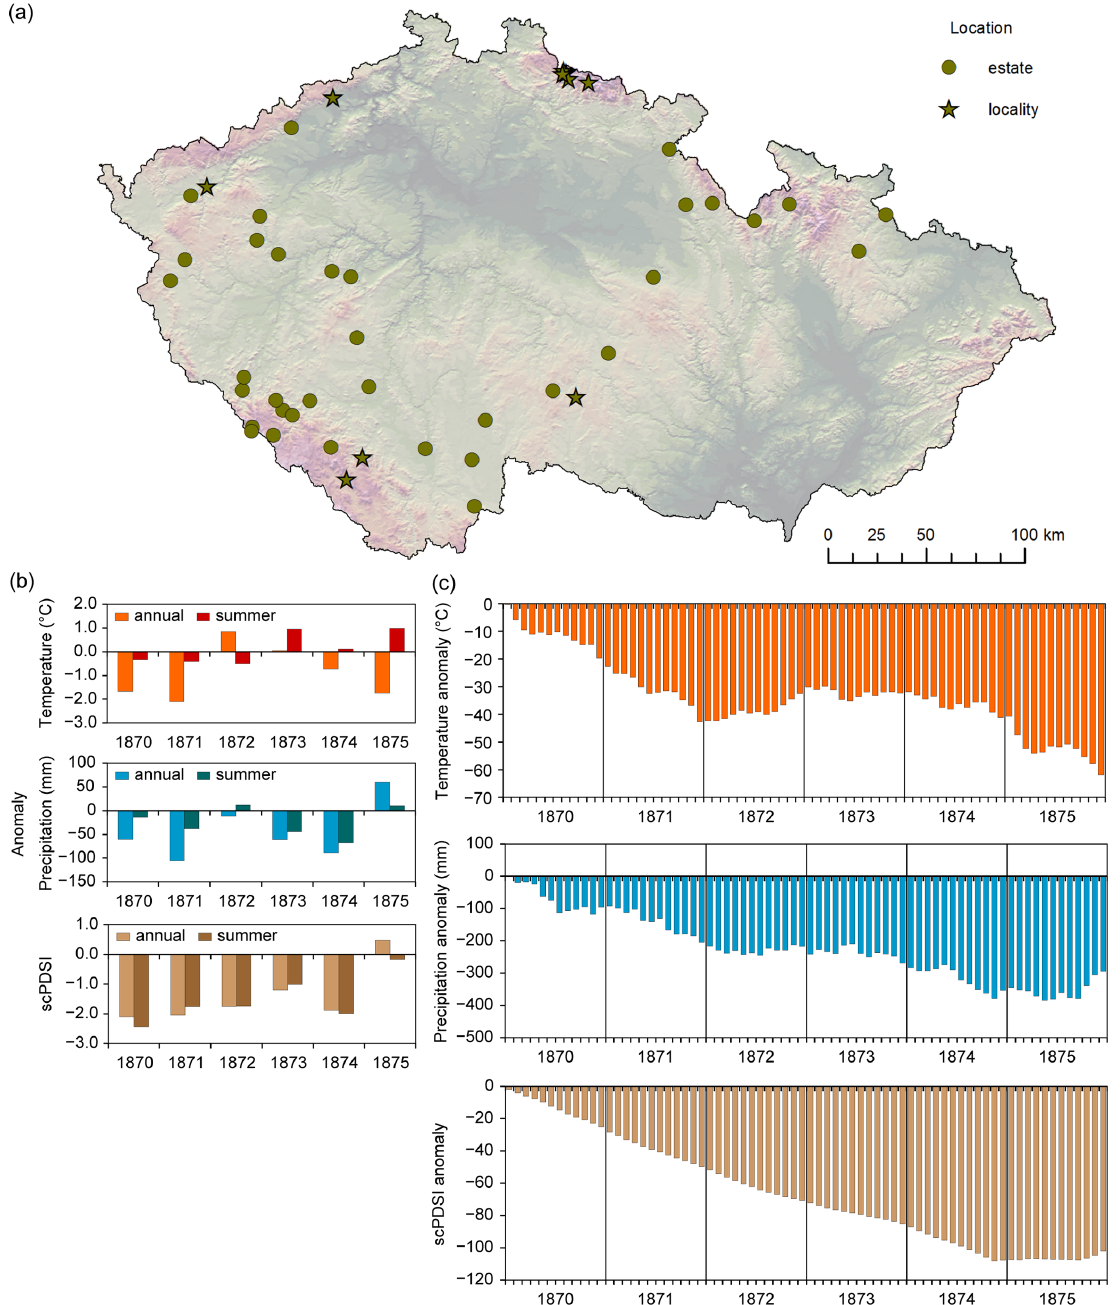
Figure 5. Bark beetle outbreak of the 1870s on the territory of the Czech Republic: (a) locations with the occurrence of bark beetle; (b) annual and summer anomalies of temperature, precipitation, scPDSI-12, and scPDSI-3 in 1870–1875; (c) cumulative monthly anomalies of temperature, precipitation, and scPDSI in 1870–1875 (1961–1990 reference